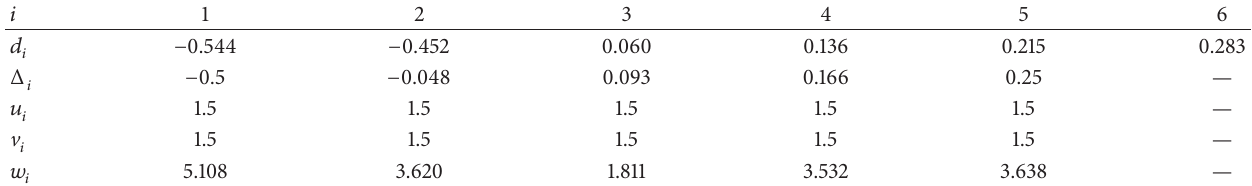
Table 8: Numerical results of Figure 4(d).